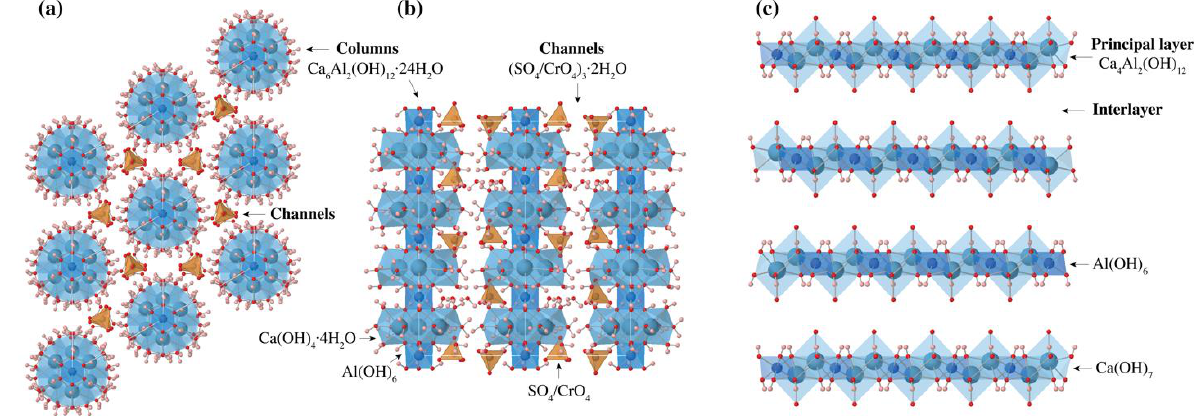
Figure 1. Illustrations of the crystal structures for ( a ) AFt (projection along [001]), ( b ) AFt (projection along [100]), and ( c ) AFm (projection along [100]) phases.